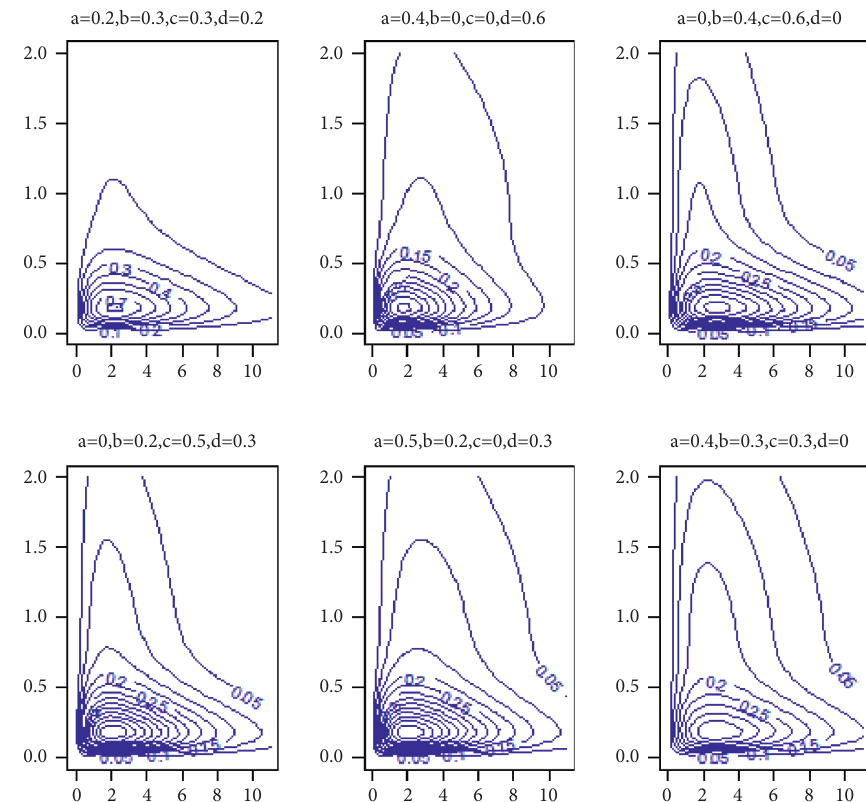
Figure 2: The contour plots of BMEE distribution for varying parameter choices in equation